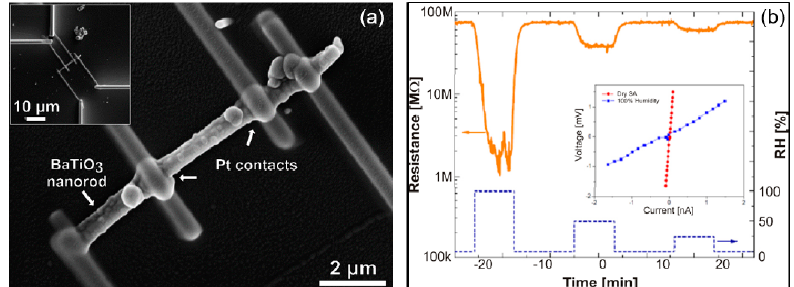
Figure 3. ( a ) Detail of a BaTiO 3 nanorod contacted with FIB nanolithography in 4-probe configuration. The inset in the upper left corner shows low-magnification image of the same device. The platinum strips deposited with FIB are clearly shown. ( b ) Sensing response of individual BaTiO 3 nanorod towards pulses of 100, 50 and 25% of relative humidity (RH) measured at room temperature. Synthetic air was used herein as carrier gas. The inset shows I-V curves obtained in dry and humid (100% RH) air. A sharp and reversible modulation of the electrical response was